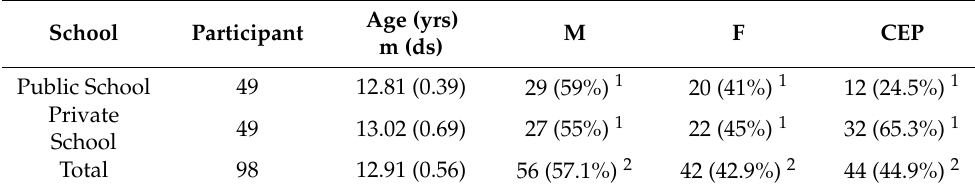
Table 1. Description of school, sex and age of participants.